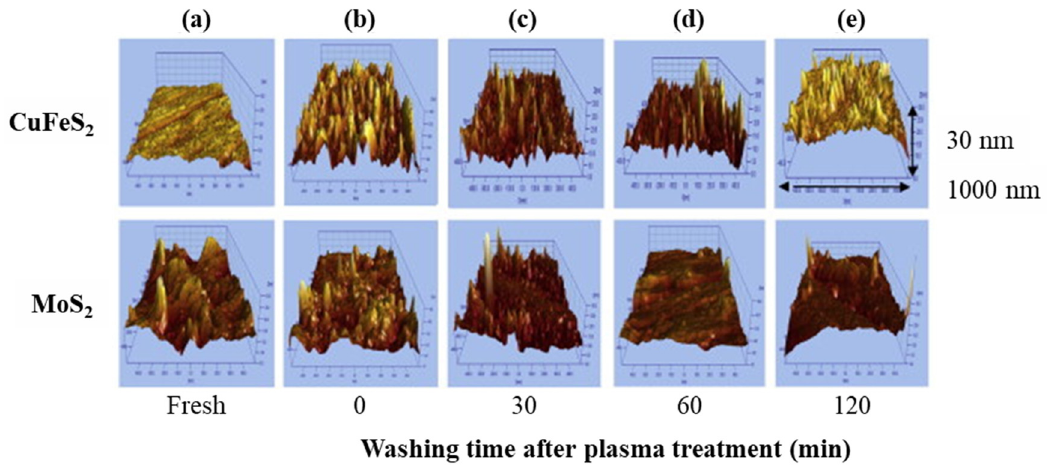
Figure 12. AFM images of chalcopyrite and molybdenite: ( a ) untreated samples and one treated with plasma at 10 W for 10 min followed by washing by pH 9 solution for ( b ) 0, ( c ) 30, ( d ) 60, and ( e ) 120 min (reprinted with permission from Hirajima et al. [74], copyright (2014) Elsevier).